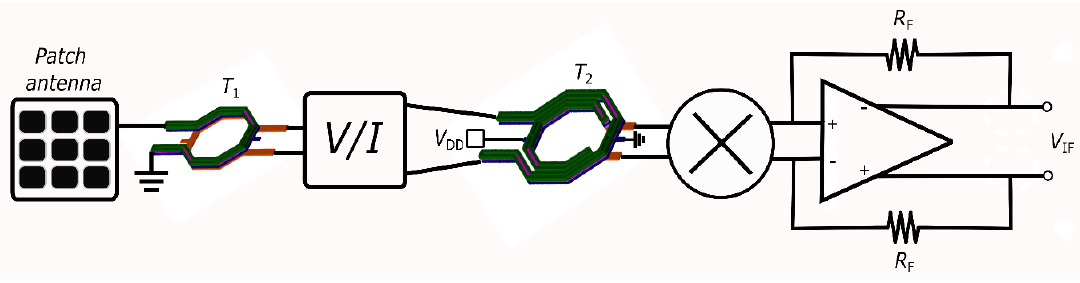
Figure 4. Simplified block-diagram of the down-converter architecture using integrated stacked transformer ( T 1 ) and interleaved ( T 2 ) transformer.